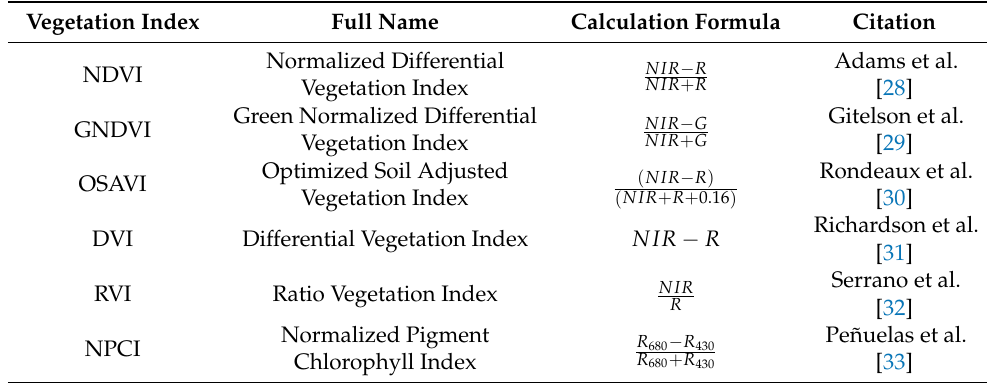
Table 1. Vegetation index and its calculation